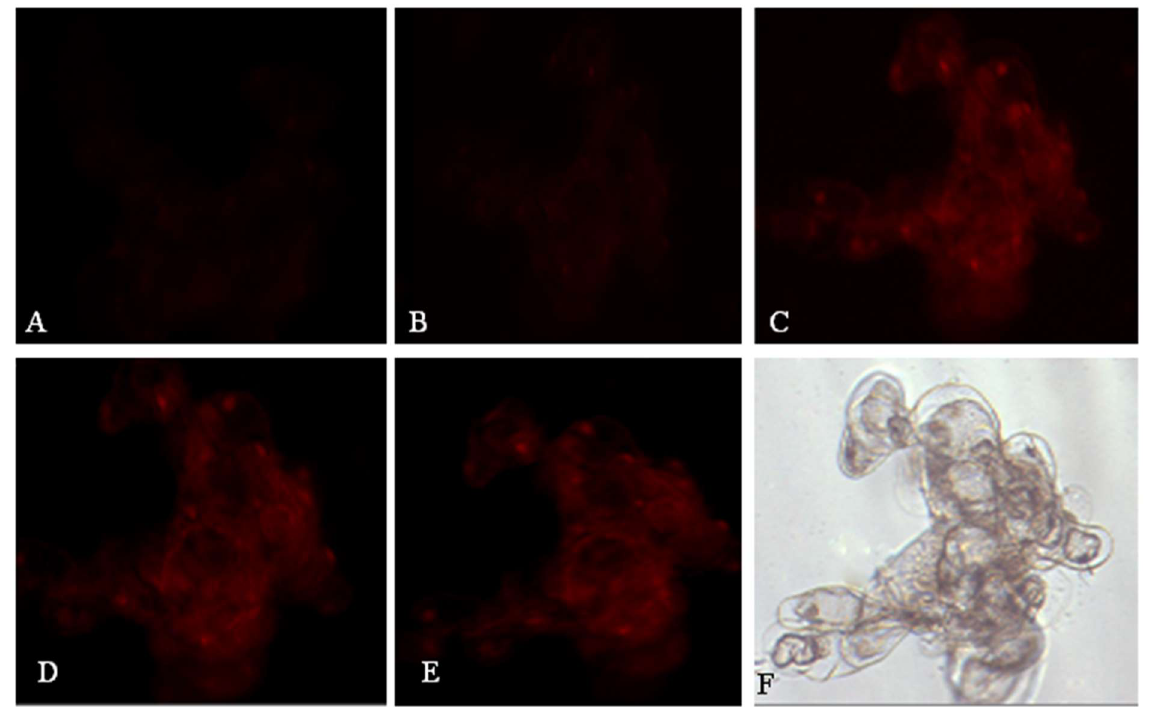
Figure 3. Serial fluorescence images loss of nuclear membrane integrity after the treatment of 1 mmol/L OA stained by PI. The nuclear membrane maintained integration, and weak red fluorescence could be observed ( A ). After the treatment of 1 mM OA, the fluorescence began to appear (after 1 h) ( B ). The fluorescence intensity increased because the nuclear membrane integrity was lost (after 3 h) ( C ). The fluorescence intensity in cytoplasm, especially the location of nucleus, continued to increase (after 5 h) ( D ). A large amount of PI stained the nucleus, and the fluorescence intensity was evident (after 7 h) ( E ). Microscopic was photographed under the white light field from E cells, and the cells were relatively intact ( F ).